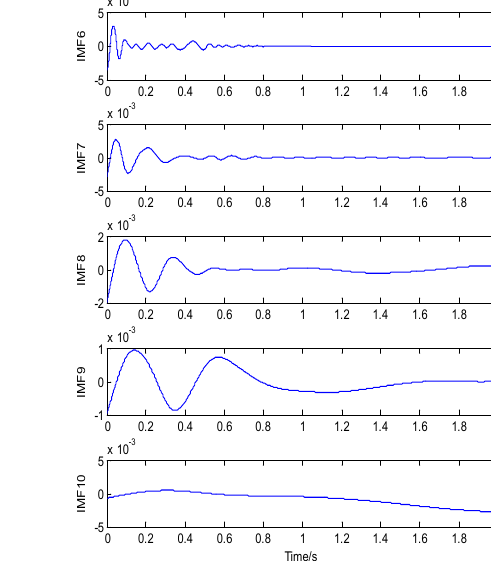
Figure 6. IMFs obtained by the first band − filtering.